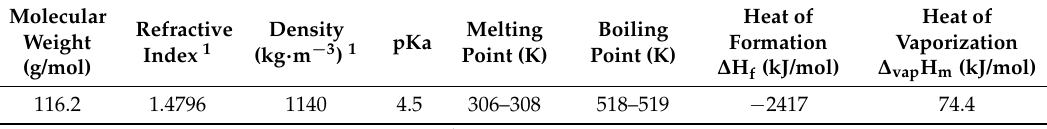
Table 1. Some physical properties of Levulinic Acid (LA).